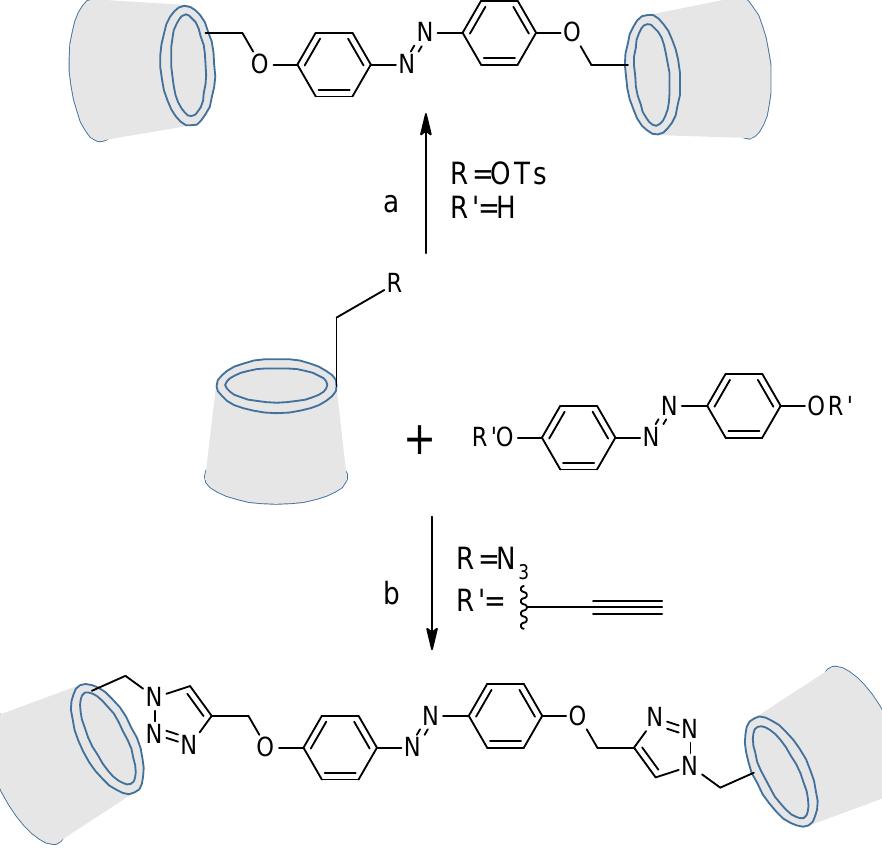
Figure 18. Ways of syntheses. a. Cs 2 CO 3 , DMF, 90 °C, 24 h ; b. (EtO) 3 P·CuI, DMF, 100 °C, 2 h.